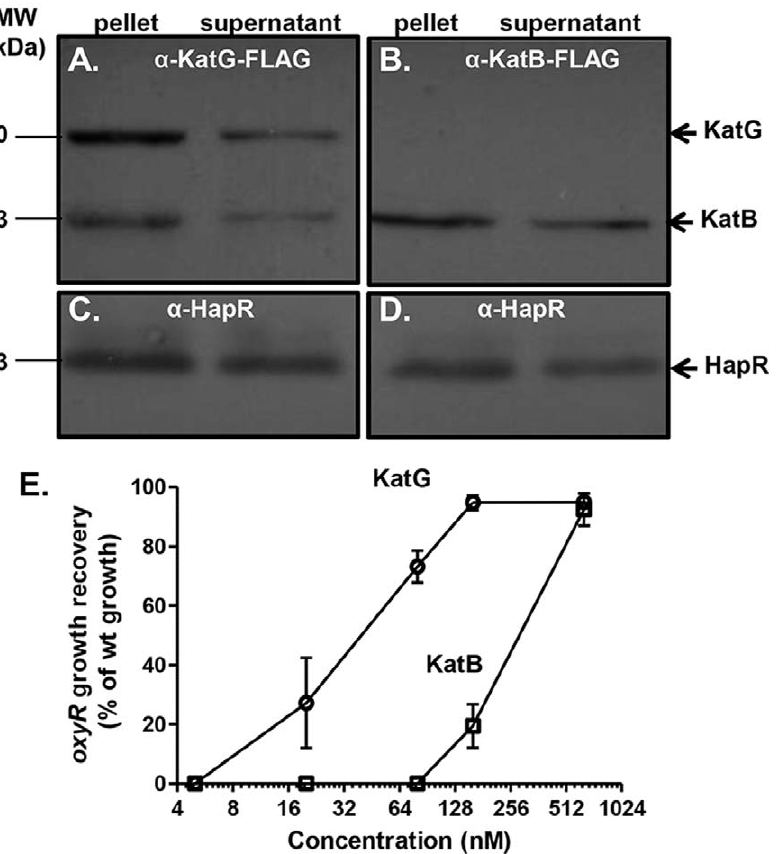
Figure 5. KatG and KatB localization and their oxyR growth promoting activity. A–D. V. cholerae containing either P BAD - katG-flag ( A, C ) or P BAD - katB-flag ( B, D ) were grown on LB agar plates containing 0.1% arabinose. Western-blot analysis to detect FLAG-tagged KatG and KatB as well as a cytoplasmic protein control HapR in the cell pellets (from 25 m l of OD 600 =3.0 cultures) and culture supernatants (concentrated from 1 ml of OD 600 =3.0 cultures). Anti-FLAG antibody and anti-HapR antibody [20] were used. E. Purified KatG and KatB restored the oxyR growth defect. Overnight cultures of oxyR mutants were inoculated 1:1000 into fresh LB containing the concentrations of purified KatG-His 6 or KatB-His 6 indicated and shaken at 37 u C. OD 600 was measured after 8-hr incubation and compared to wildtype growth.